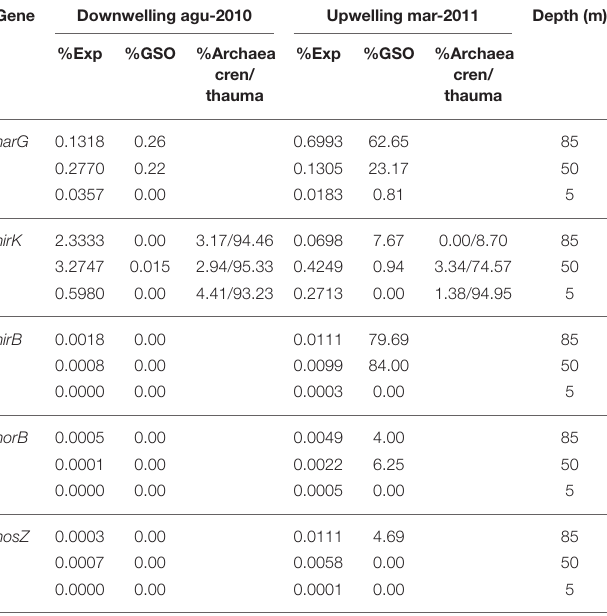
TABLE 2 | Percentage of relative expression for key genes in carbon and sulfur cycles and their taxonomic affiliation to GSO group. Gene Downwelling agu-2010 Upwelling mar-2011